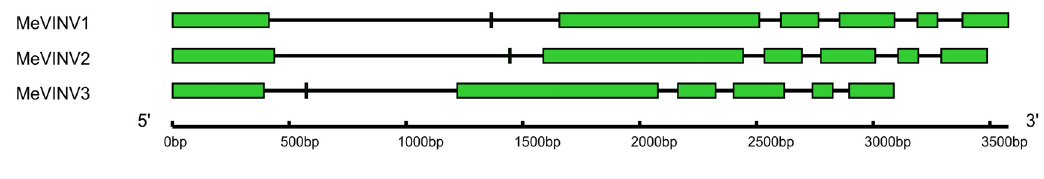
Figure 4. Exon-intron structures of three cassava vacuolar invertases in the cassava genome. Introns are shown as black lines, exons are shown as green